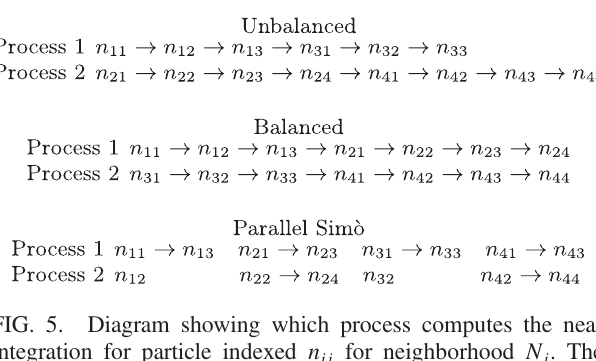
for neighborhood N . The ij i